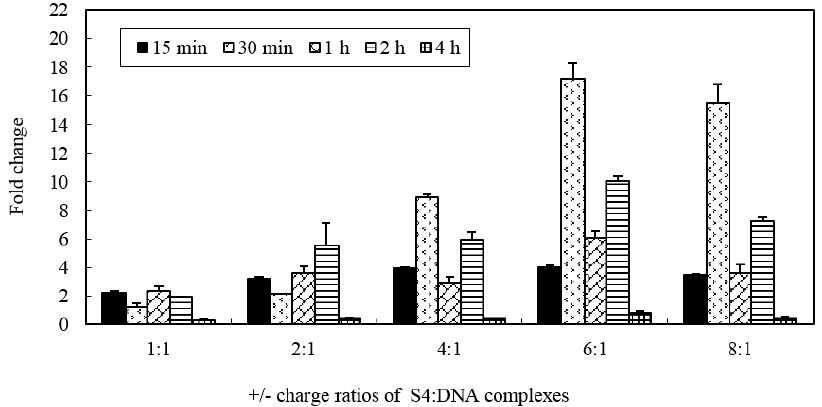
Figure 5. Expression of vp5 gene in CIK cells following gene delivery with S4: DNA complexes at various charge ratios. Each MWCNTs-NH 3+ :DNA charge ratios were tested with five different incubation time periods groups. Data are means for three assays and presented as the means ± standard error.